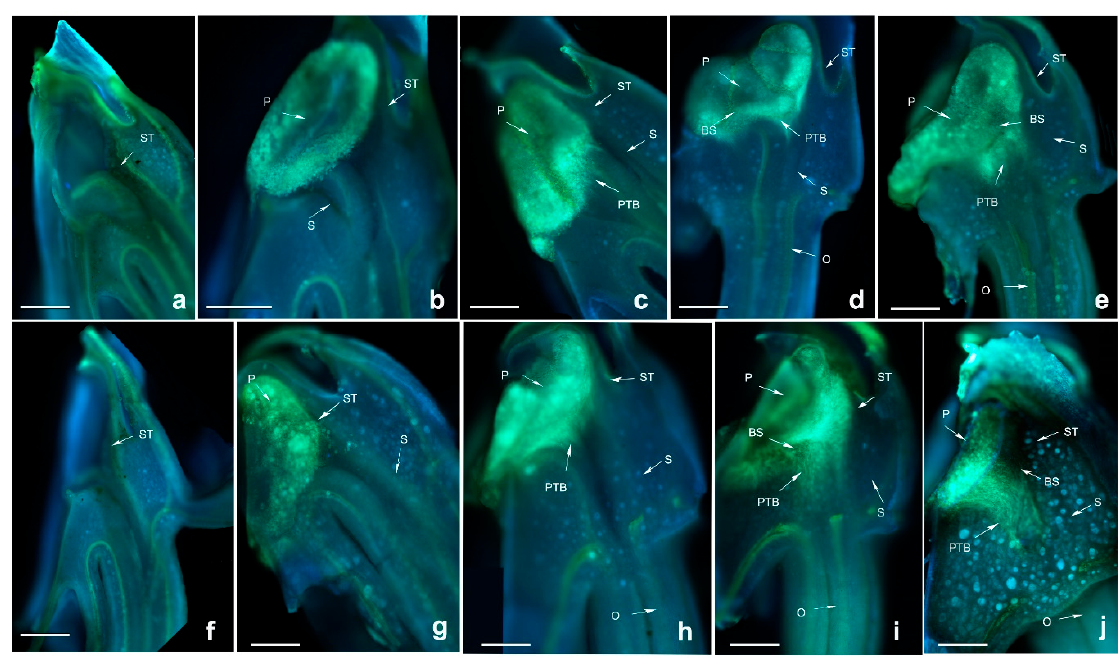
Figure 3. Growth of pollen tubes after self- and cross-pollination of Dendrobium devonianum. ST: stigma; P: pollinium; S: style. BS: black spots; PTB: pollen tube bundle; O: ovary. ( a ) 24 h after cross-pollination; ( b ) 48 h after cross-pollination; ( c ) 72 h after cross-pollination; ( d ) 96 h after cross-pollination; ( e ) 120 h after cross-pollination; ( f ) 24 h after self-pollination; ( g ) 48 h after self-pollination; ( h ) 72 h after self-pollination; ( i ) 96 h after self-pollination; ( j ) 120 h after self-pollination. Bars = 100 µm.